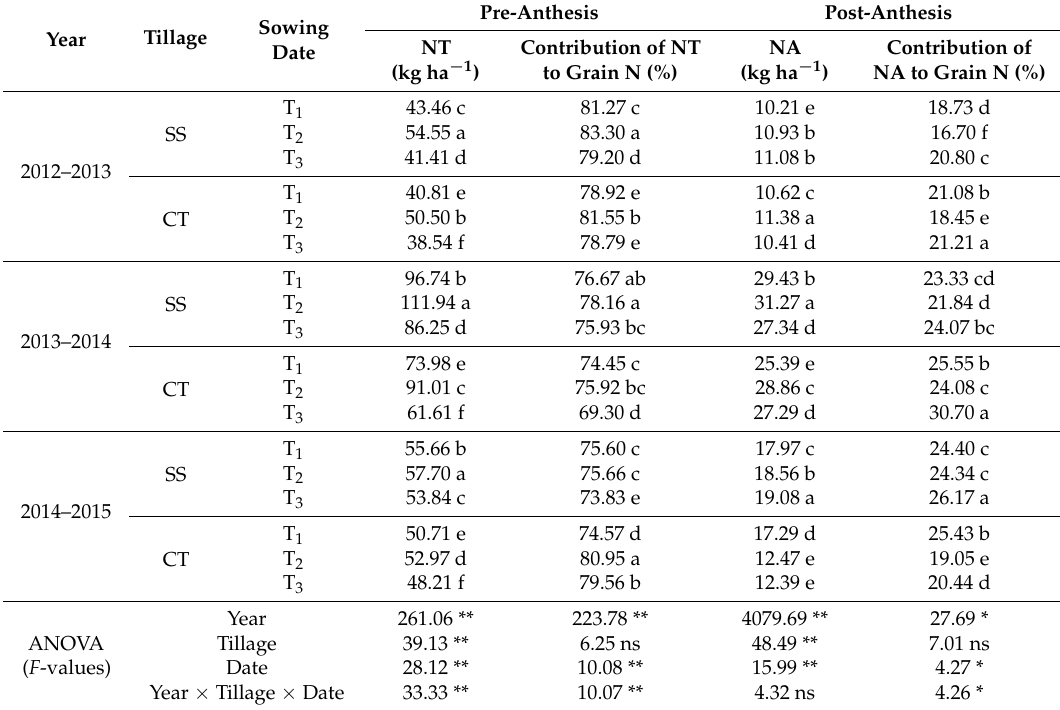
Table 2. Effect of subsoiling and sowing dates on pre-anthesis nitrogen translation and post-anthesis nitrogen accumulation to grain